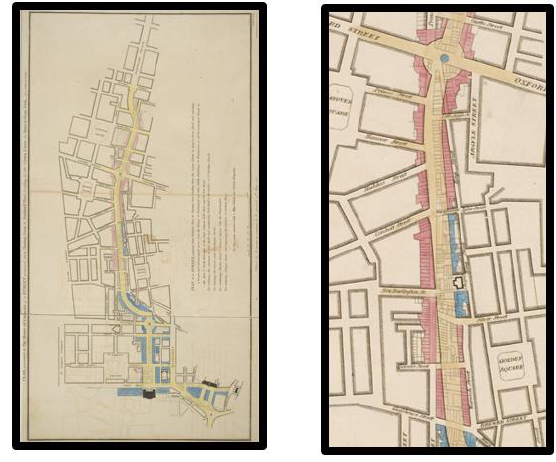
Figure 5: Faden, W (1814) Plan of a street. (URL 3)